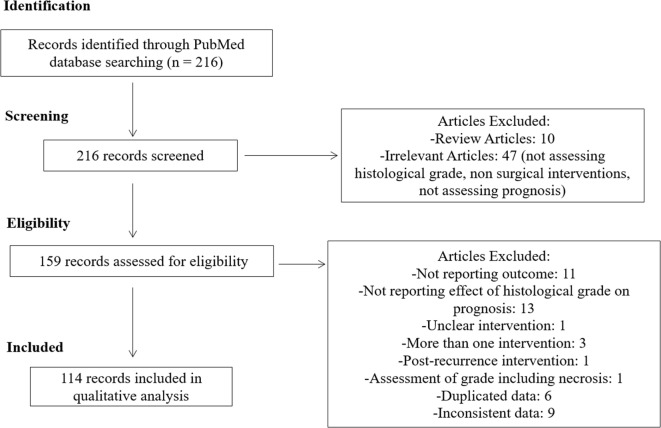
Flow diagram of the study selection process.